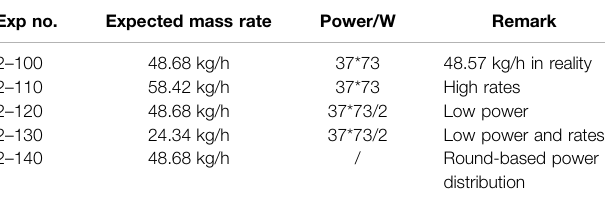
TABLE 4 | Five groups of working conditions under different mass fl ow rates and heating power distributions. Exp no.